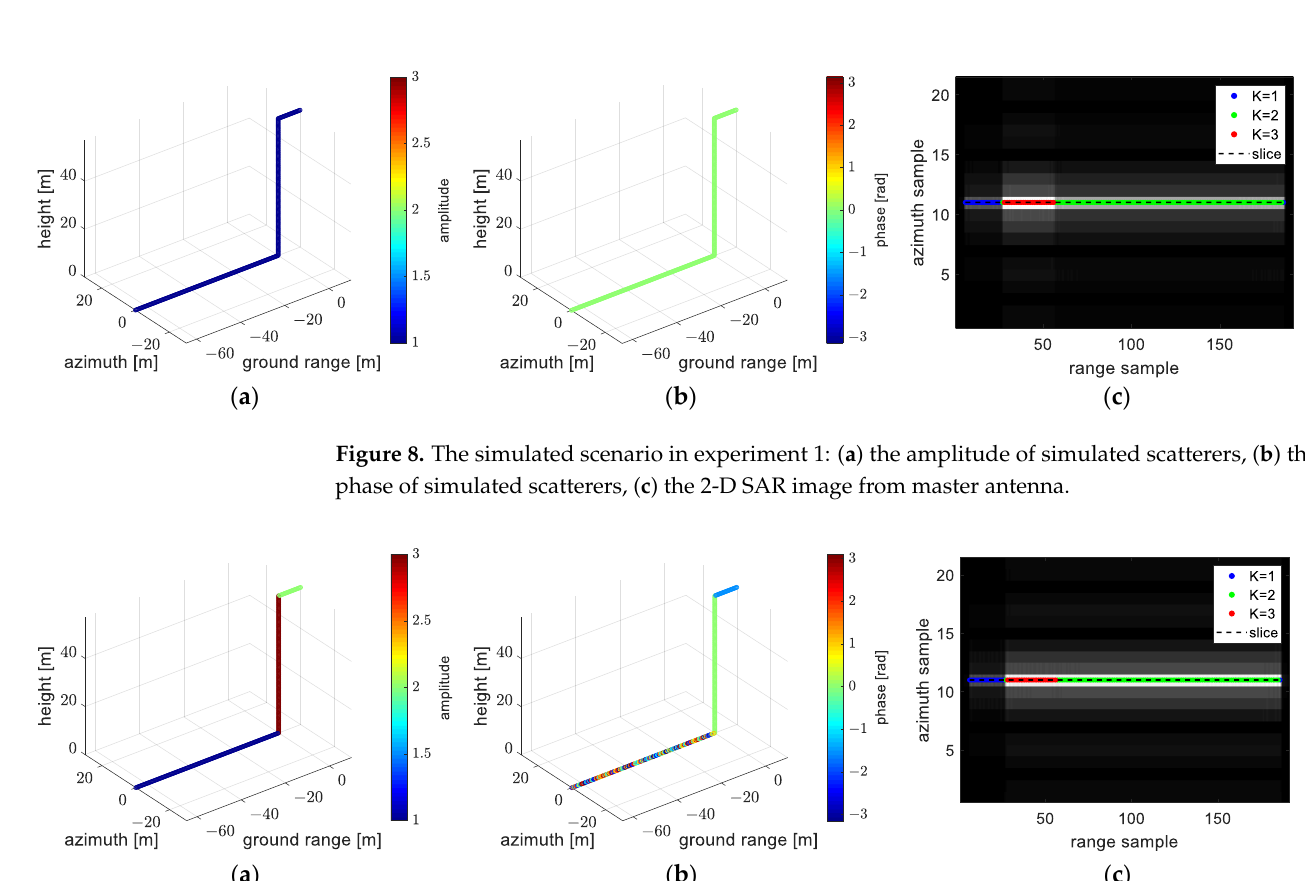
( b ) Figure 7. ( a ) Configuration of the antenna array; ( b ) structure of the simulated scene in ground frame. For the sake of computational efficiency, we simulate only one scatterer in azimuth direction, and slice a line containing scatterers in the stack of SAR images to perform tomographic processing. In order to better calculate the inversion error of scatterers, every scatterer is located on the sampling grids in both azimuth direction and range direction. By this means, there will be no error between simulated scatterers and estimated scatterers in the azimuth and range directions. We only need to analyze the error between them in ground range and height direction. Referring to Equation (16), the length 𝐿 of the effective integral interval under the planar wavefront models is about 37 m and 37.61 m at the near and far ends of the illumi- nated scene, respectively. Referring to Equation (15), the maximum length 𝐿 max of the ef- fective integral interval under the planar wavefront models is 52.33 m and 53.18 m at the near and far ends of the illuminated scene, respectively. The height of the scene is about 57 m and the off-nadir angle of the center of the scene is about 45 ° . Therefore, the extension in the elevation direction is about 81 m. The lengths 𝐿 and 𝐿 max are smaller than the length of the extension of the illuminated scene. In experiment 1, all the simulated scatterers have the same amplitude and phase as shown in Figure 8. The phase and amplitude of scatterers are 1 and 0 rad, respectively.